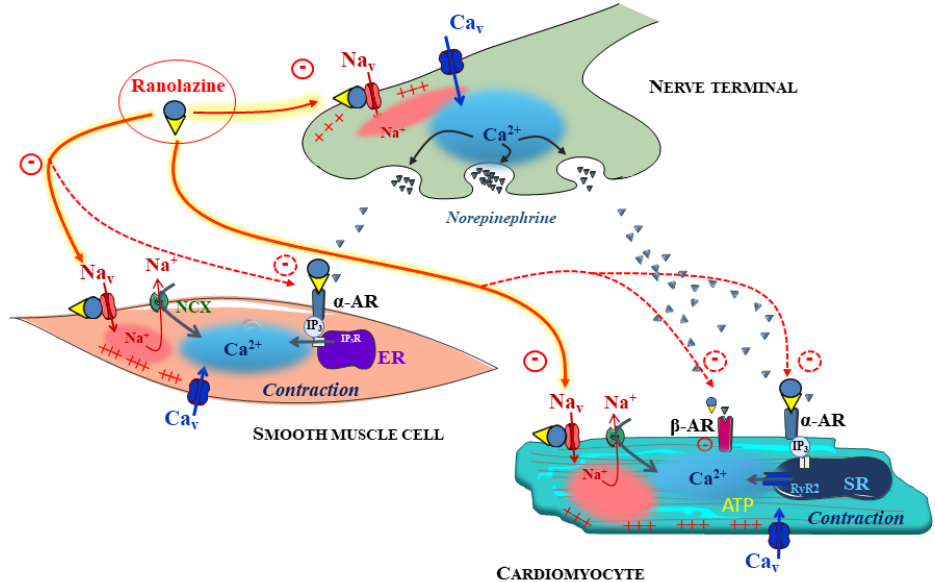
Figure 4. Integrated vision of ranolazine’s putative direct and indirect effects on the cardiovascular system. The therapeutic benefits of ranolazine in the treatment of ischemia and angina pectoris have